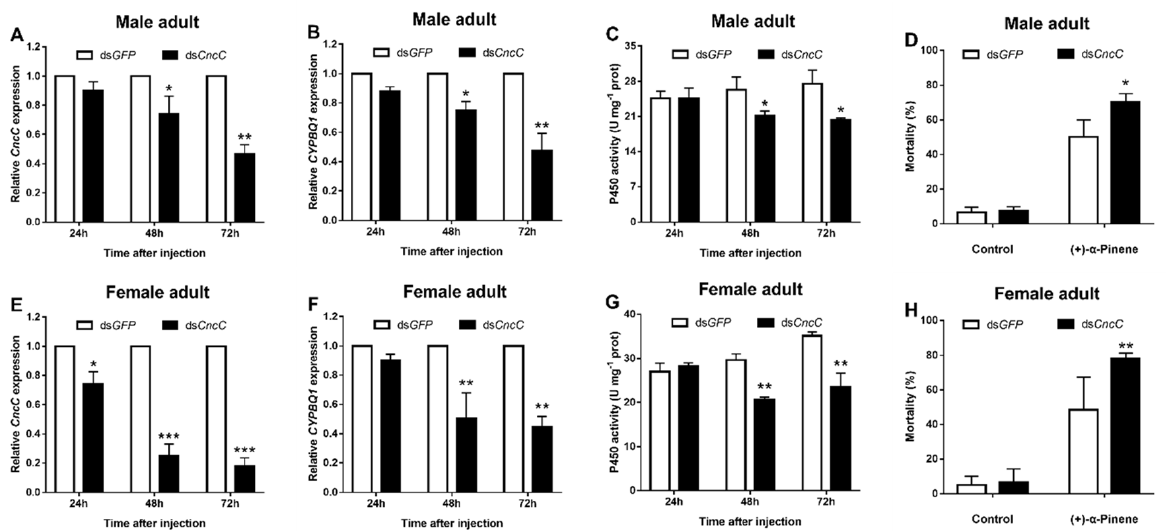
Figure 4. Silencing CncC suppresses CYP4BQ1 expression and reduces adults’ tolerance to (+)- α - pinene. Adults of D. armandi were treated with dsRNA for 24, 48, and 72 h after injection. The expression levels of CncC ( A , E ) and CYP4BQ1 ( B , F ) were detected by RT-qPCR. The P450 activities of midgut ( C , G ) were determined after RNAi. The mortality ( D , H ) of adults exposed to LC 50 (+)- α -pinene was assessed at 48 h after dsRNA injection. The asterisk indicates a significant difference between treatment groups (* p < 0.05, ** p < 0.01, *** p < 0.001, independent Student’s t -test). All values are the mean ± SE, n = 3.